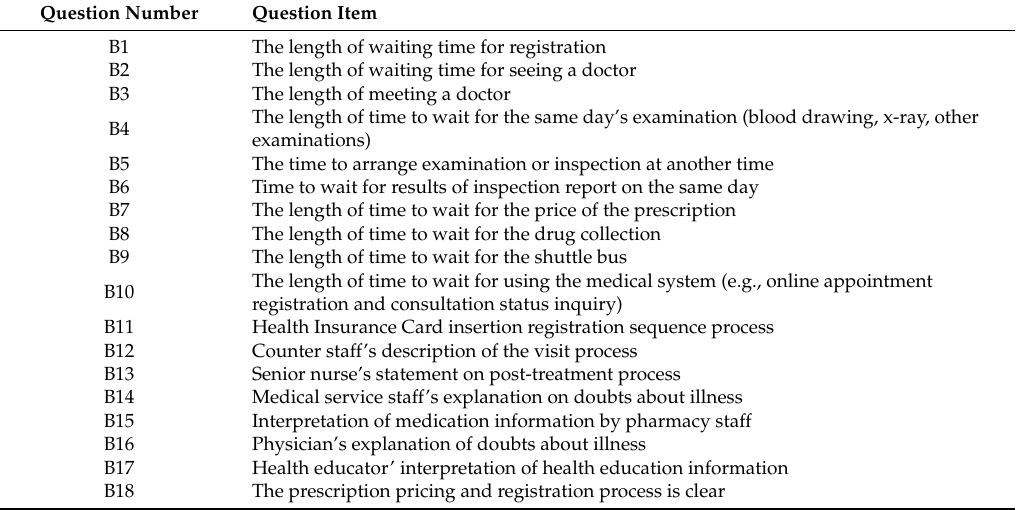
Table 13. Scale of medical process service dimension.